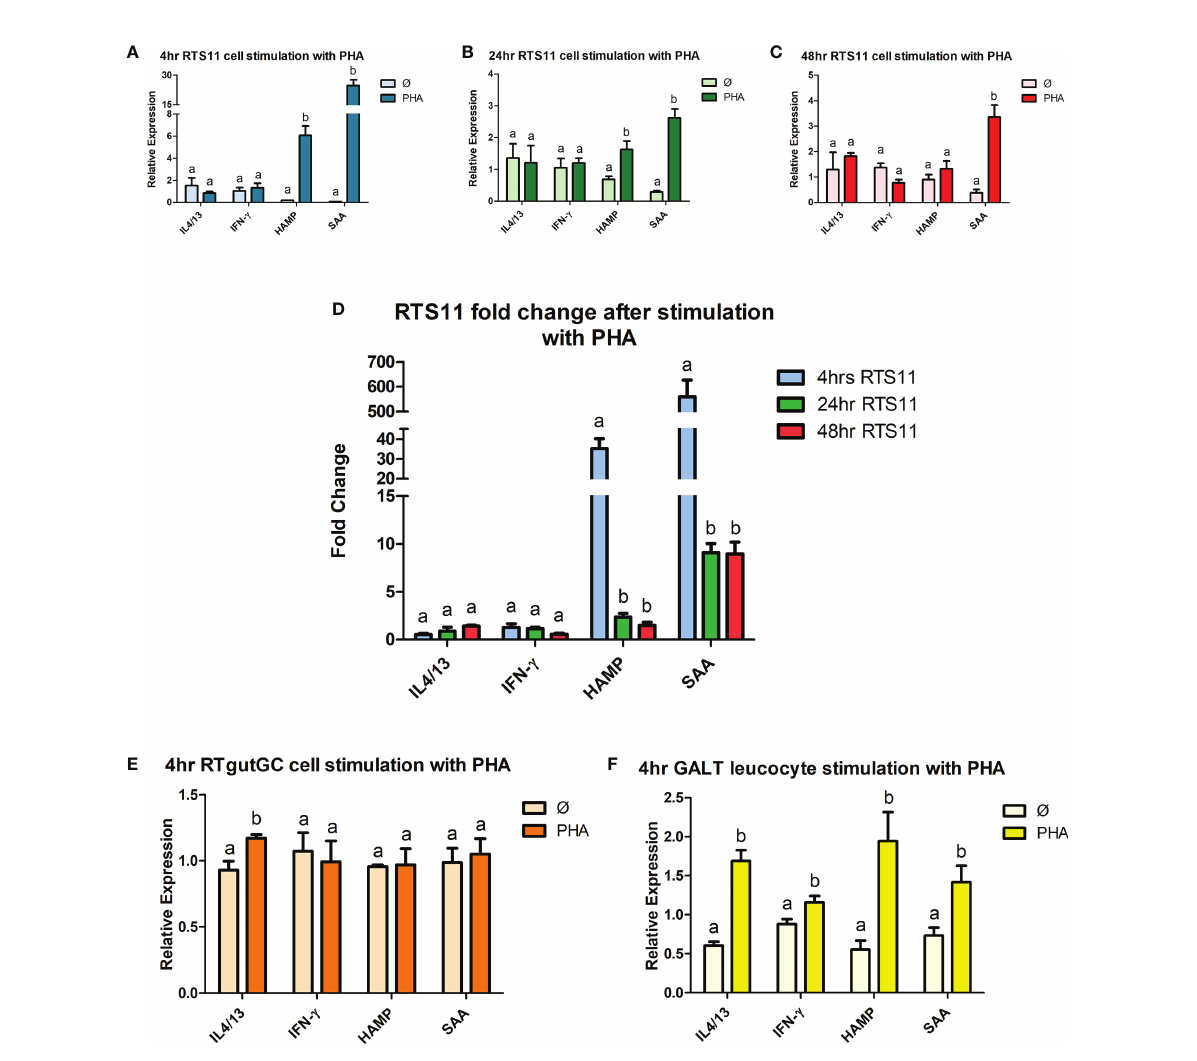
FIGURE 2 RTS11, RTgutGC and GALT leucocyte response to PHA. (A) RTS11 4hr PHA stimulation showing relative expression. (B) RTS11 24hr PHA stimulation showing relative expression. (C) RTS11 48hr PHA stimulation showing relative expression. (D) RTS11 Fold Change between time points (4, 24 and 48 hr). (E) RTgutGC 4hr PHA stimulation showing relative expression. (F) GALT leucocyte 4hr PHA stimulation showing relative expression. For relative expression samples were compared between stimulated and unstimulated samples. a and b denote a signi fi cant difference where p <